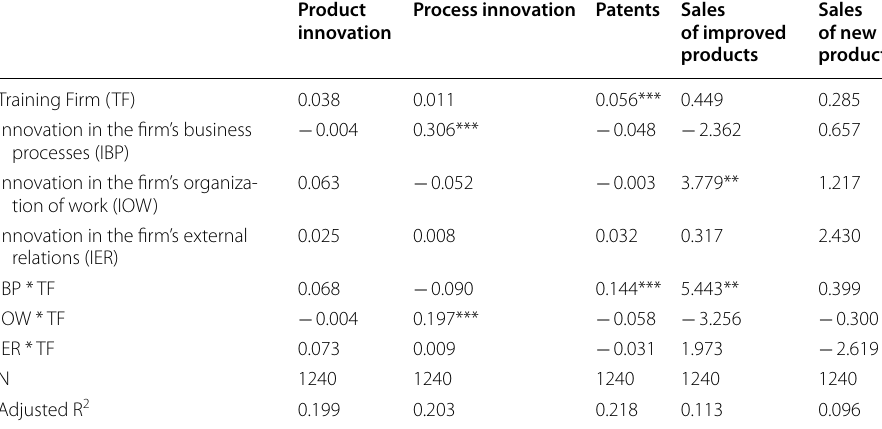
Table 3 Moderating effects of hybrid change agents (OLS